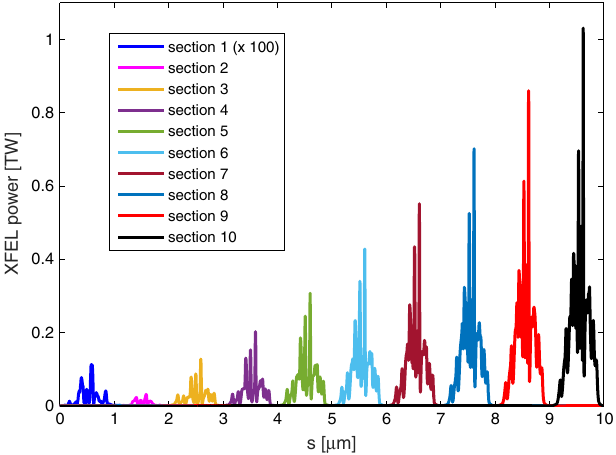
FIG. 5. XFEL peak power at 1 Å along the longitudinal position of the electron bunch after each undulator section for the case with an initial tilt amplitude of 50 in offset. The final XFEL peak power is around 1 TW, the pulse energy is around 500 μ J, and the rms pulse duration is around 500 as.